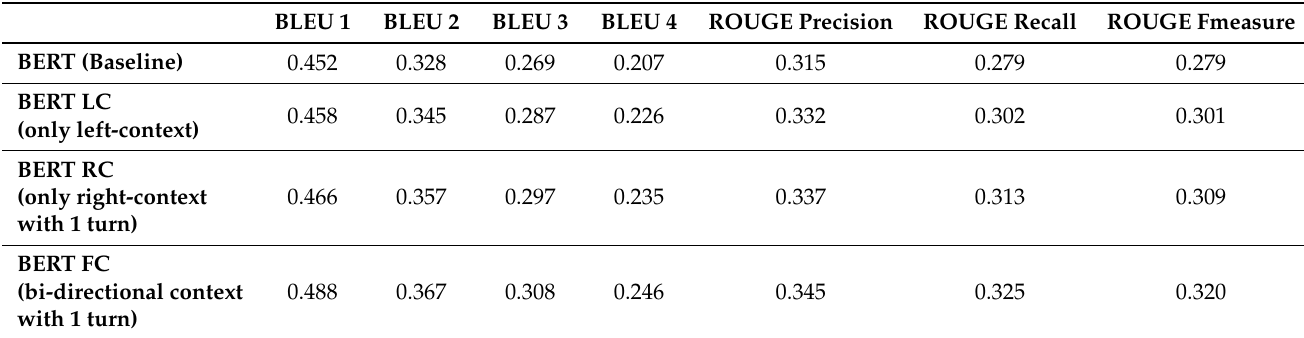
Table 2. Summarization results of different